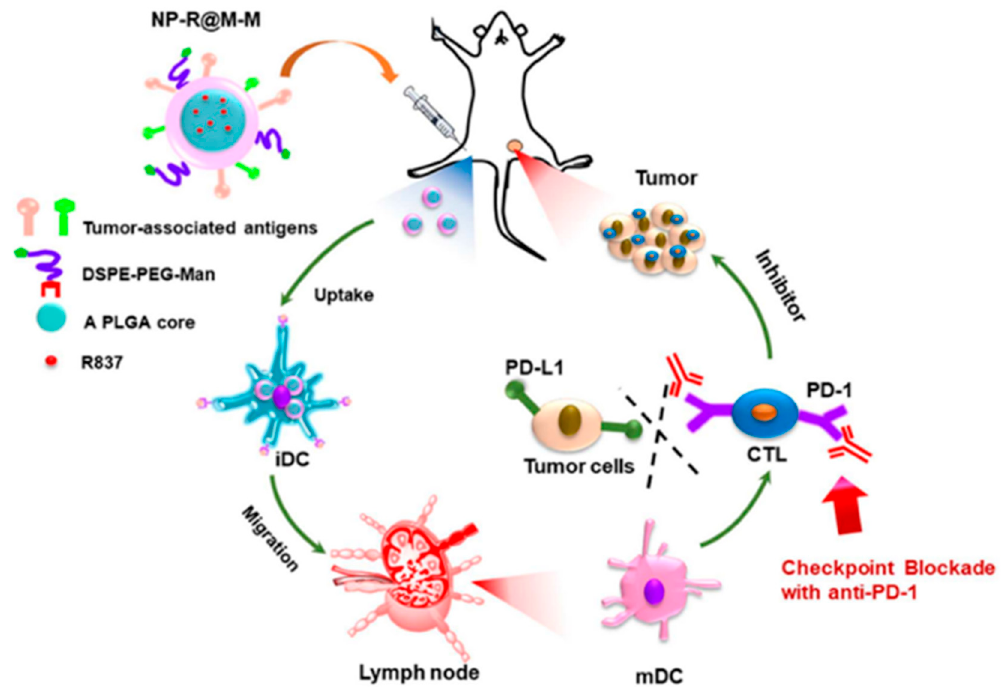
Figure7. Schematicofthecancercellmembrane-coated,R837loaded,andmannosemodifiedpoly(lactic- co -glycolic Figure 7. Schematic of the cancer cell membrane-coated, R837 loaded, and mannose modified acid) (PLGA) nanovaccine for anticancer vaccination. Reproduced with permission from Ref [52], Copyright © poly(lactic- co -glycolic acid) (PLGA) nanovaccine for anticancer vaccination. Reproduced with 2018, American Chemical permission from Ref [52], Copyright © 2018, American Chemical Society.